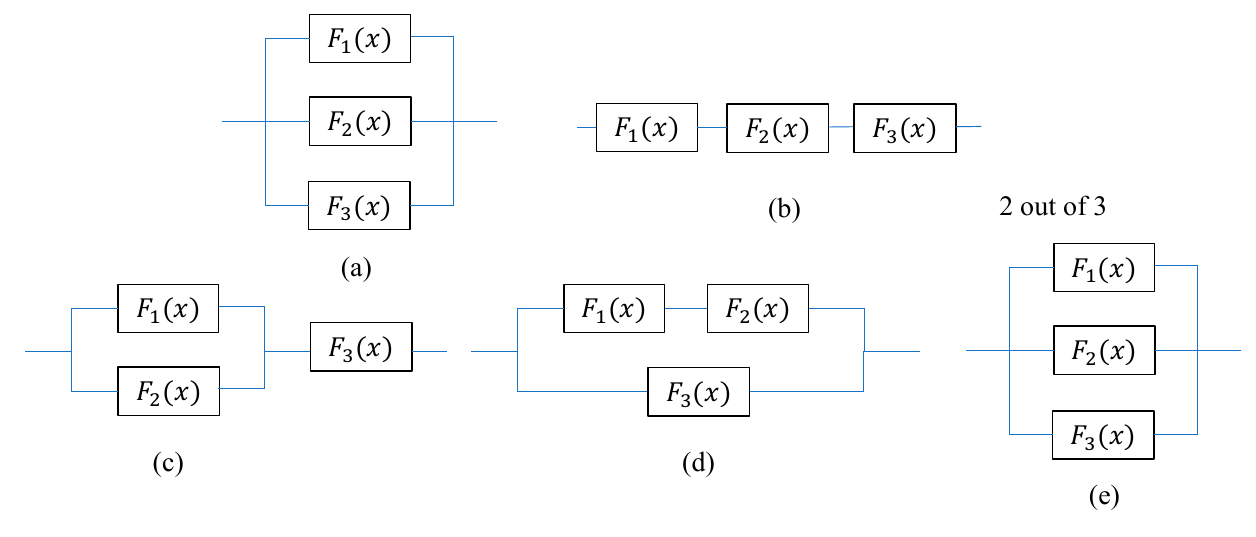
Figure 3. Structure of different failure modes for three components: ( a ) in parallel; ( b ) in serial; and ( c – e ) in a mixed system. Table 2. Joint distribution functions for a system consisting of two and three components under different failure modes and dependency conditions.